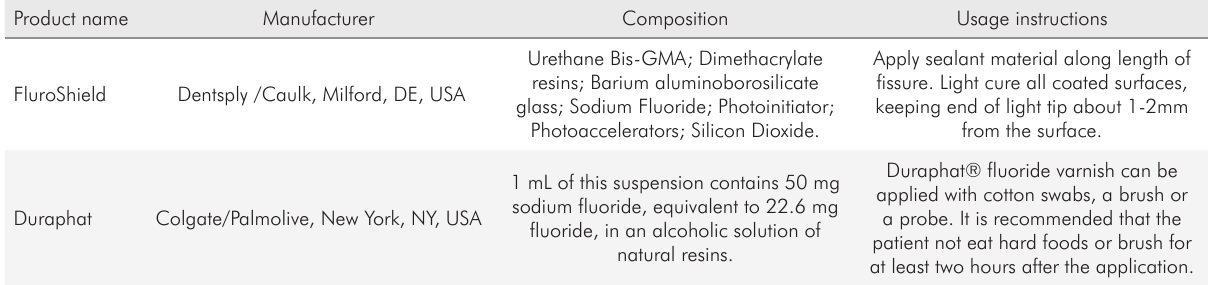
Table 1. Composition of materials used in the present study.